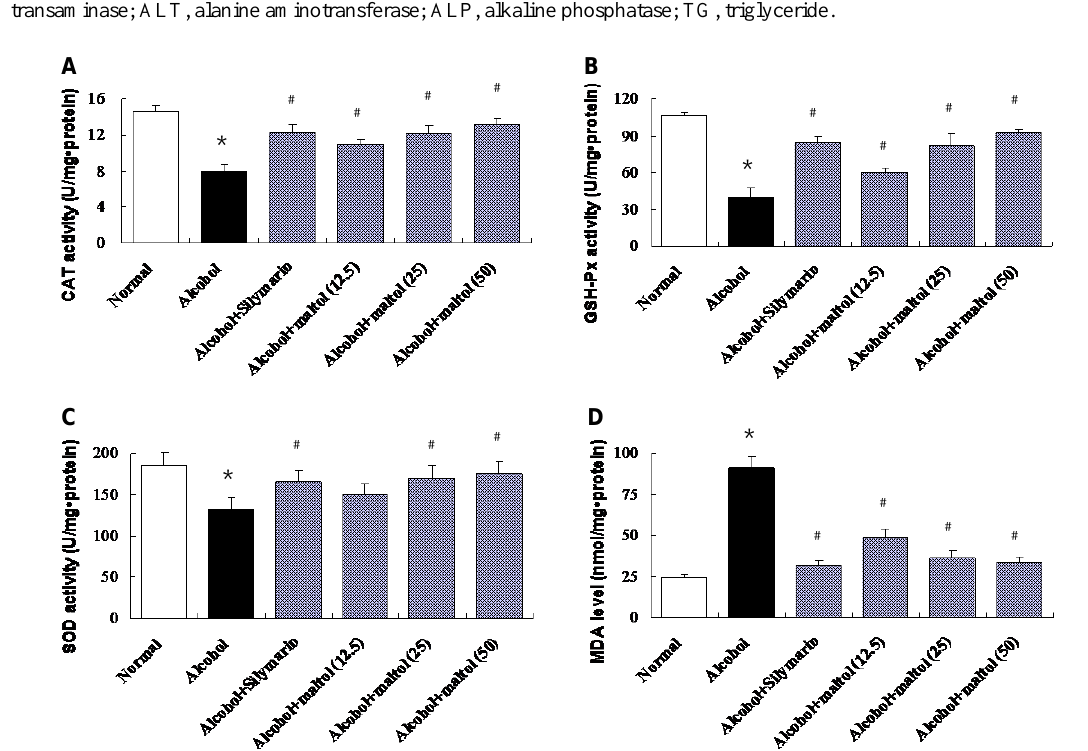
Figure 4. Effects of maltol on hepatic CAT ( A ), GSH-Px ( B ), SOD ( C ) and MDA ( D ) levels in alcohol-induced mice. Data represent the mean ± S.D. ( n = 8); Significant differences were indicated by * p< 0.05 vs. normal group; # p< 0.05 vs. alcohol group; CAT,